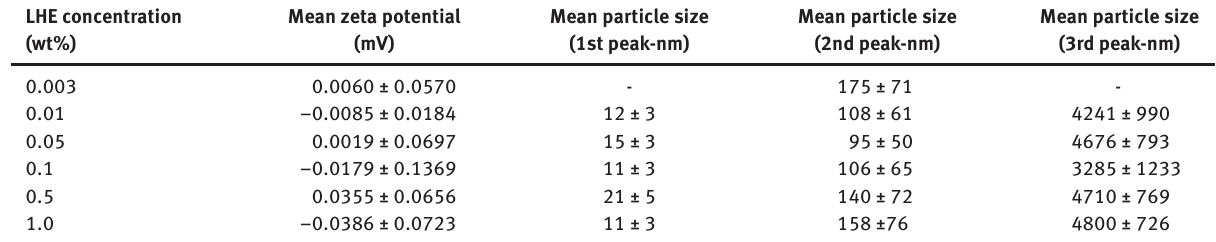
Table 1: Zeta potentials and particles sizes of AgNPs colloidal solutions obtained from LHE reduction (after heat treatment) at the concent- ration range between 0.003 to 1.0